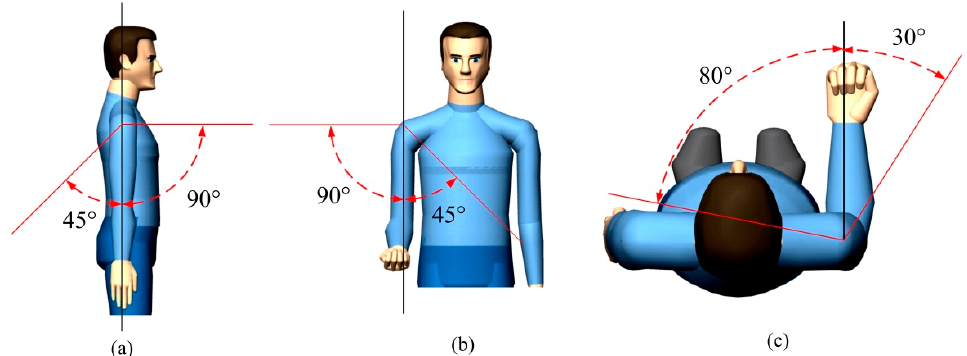
Figure 1. Shoulder joint freedom of motion. ( a ) Flexion / extension; ( b ) abduction / adduction; ( c ) internal rotation / external rotation.